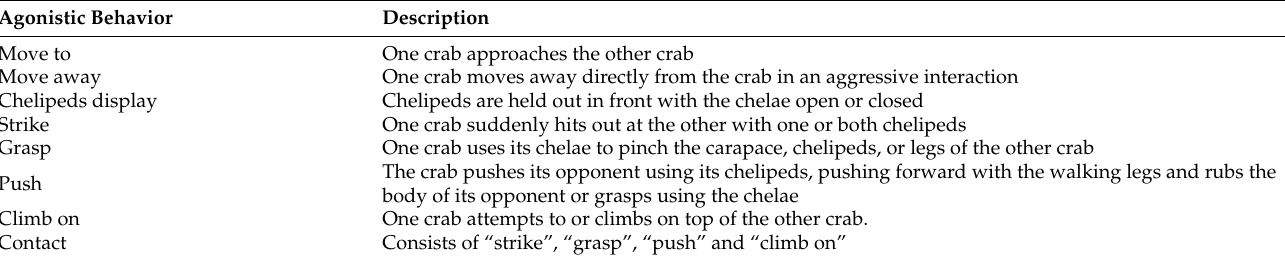
Table 2. Agonistic behavior description of swimming